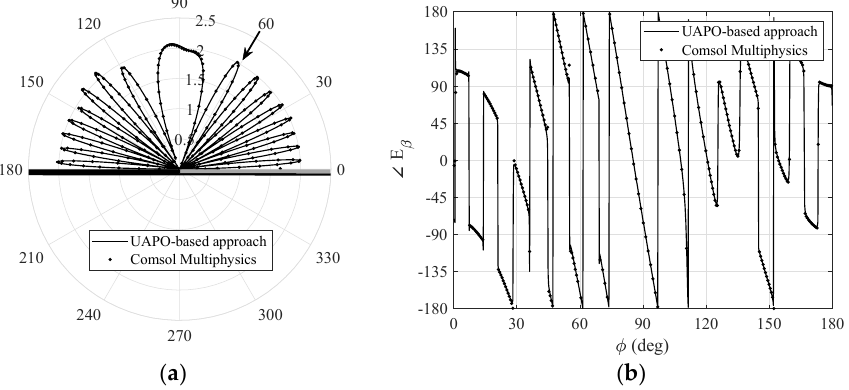
Figure 2. Case I: comparisons with Comsol Multiphysics ® data when f ' = 60 ° , E ( a ) Amplitude of the total field β –component. ( b ) Phase of the total field β –component.